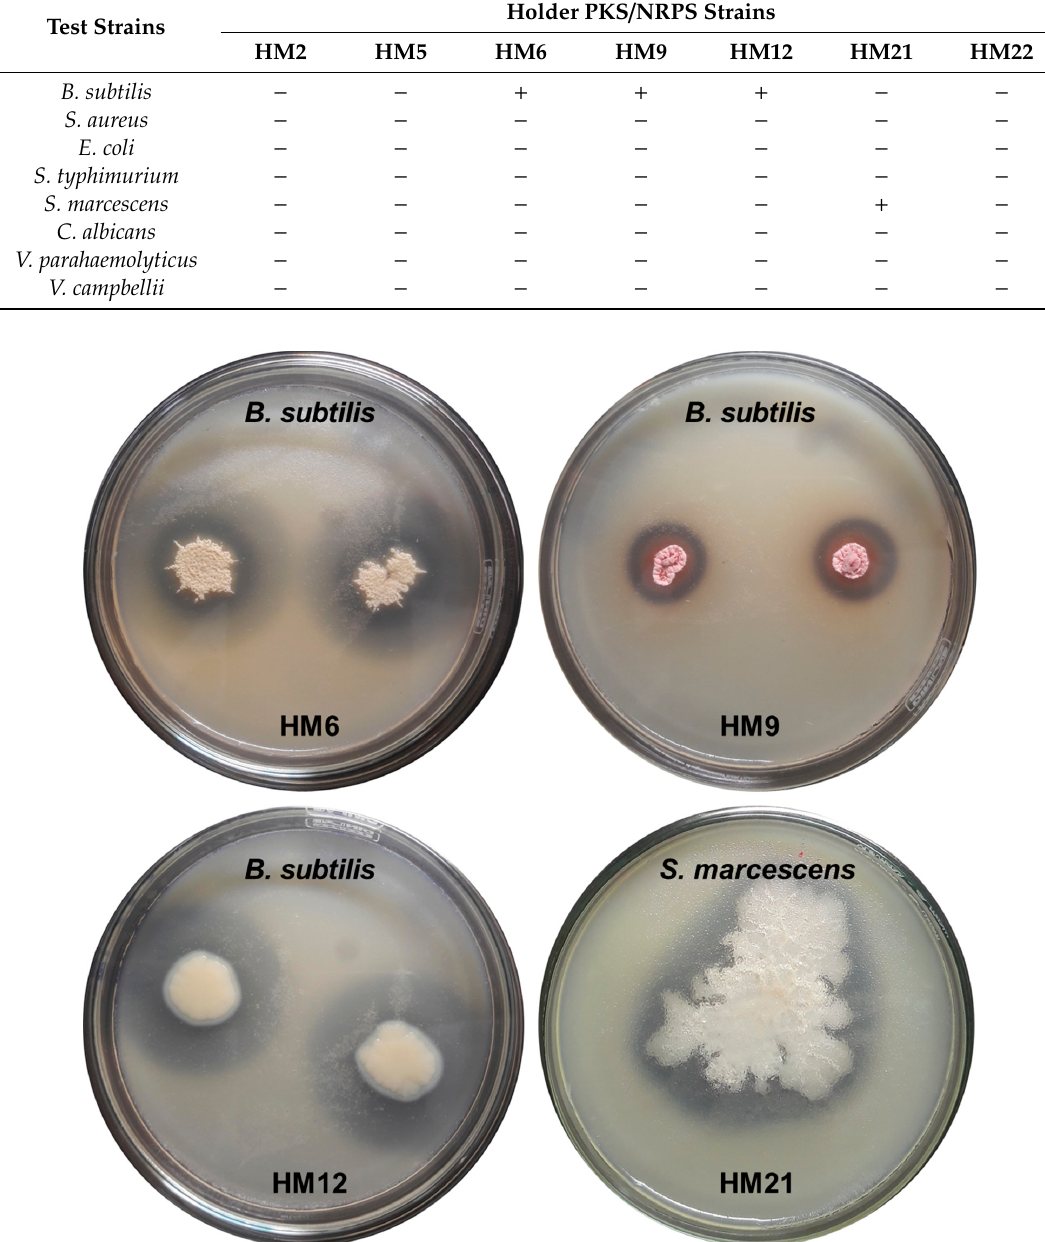
Figure 5. Antagonistic activities of SAB (sponge-associated bacteria) by colony picking method. The pattern was the test strains (such as B. subtilis and S. marcescens ) and HM# was SAB in the center of antibacterial regions.